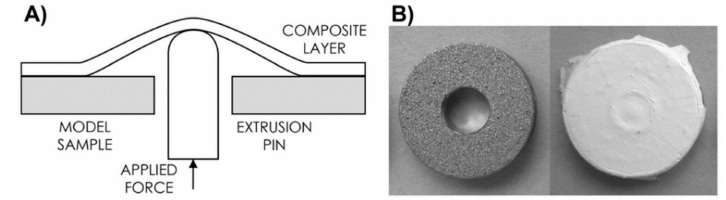
Figure 3. Diagram of the method used to measure adhesion of the composite layer to the model implant surface ( A ). Representative images of test samples before and after COL / HAp layer deposition ( B